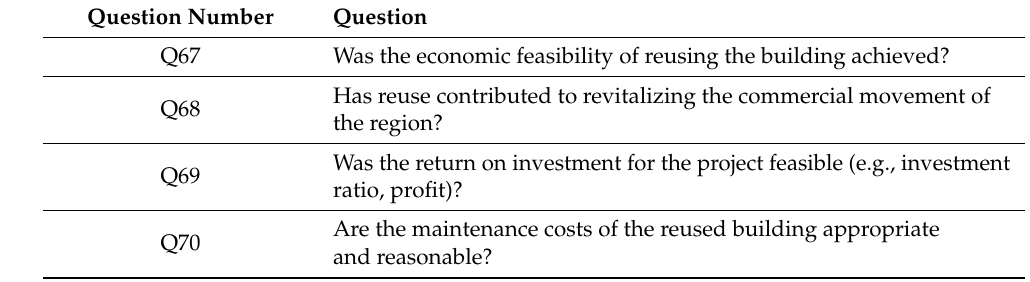
Table 14. Economic aspects questions.